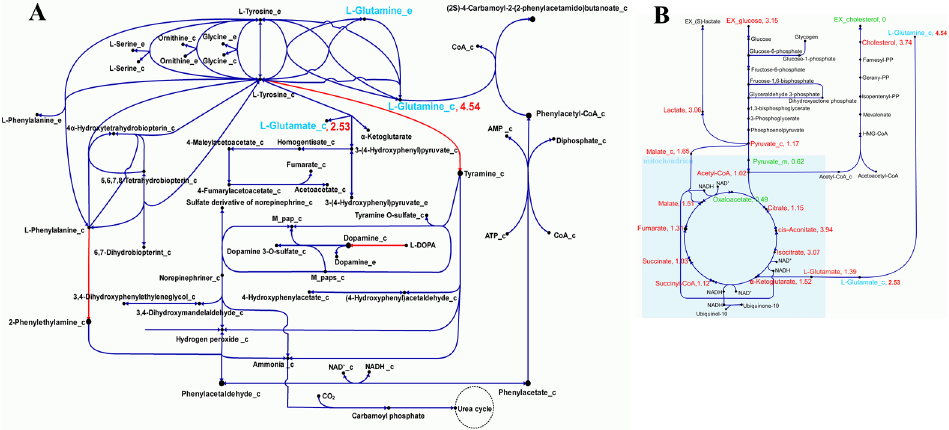
Fig 3. Metabolic reprogramming triggered by overexpression of Ddc . (A) Based on Recon2-hepatocyte model, three enzymatic reactions (red lines) are catalyzed by overexpression of Ddc. As a result of metabolic reprogramming, the fold change(FC) of the concentration of glutamineand glutamate are increasedby 4.54 and 2.53, respectively(shown in blue). (B) Elevatedexpressionof Ddc shift liver metabolismtoward glycolysis and lactate synthesis in agreementwith the hypothesisof the Warburg effect. The (FC) of metabolites in glycolysis, TCA cycle, and glutaminemetabolismpathwaysare indicatedin green (decrease) and red